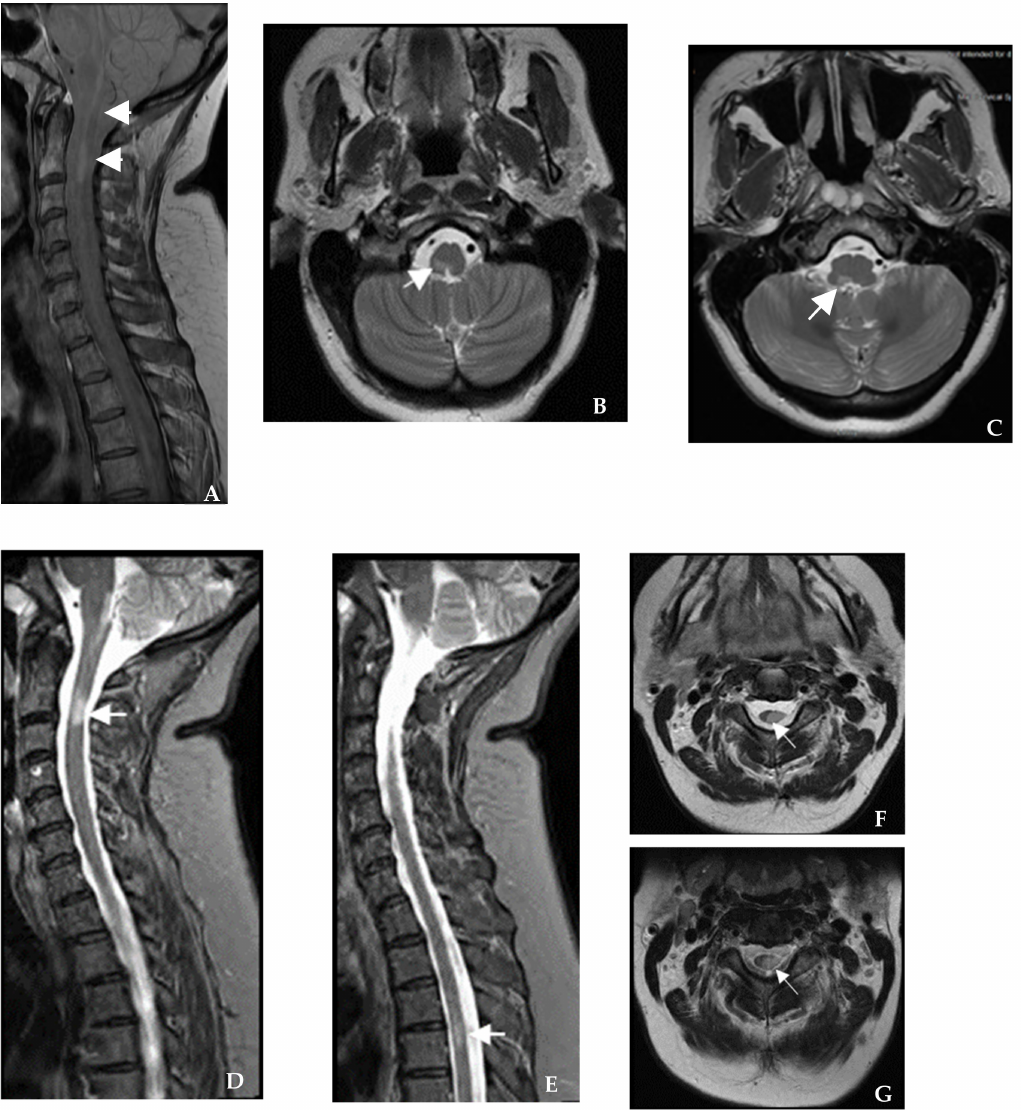
Figure 2. Case II. ( A ) Sagittal proton density brain and cervical spine MRI show an elongated lesion from the dorsal medullary area to C1–C2 (white arrows). ( B , C ) Axial cut at the specified level confirmed the lesions (white arrows). ( D , E ) Sagittal STIR cervical spine MRI shows C2–C3 and T4 cord lesions (white arrows). ( F , G ) Axial cut at the specified level confirmed the lesions (white arrows), and additionally showed involvement of the majority of the cord cross-section associated with left hemi-cord atrophy at C2–C4 ( F